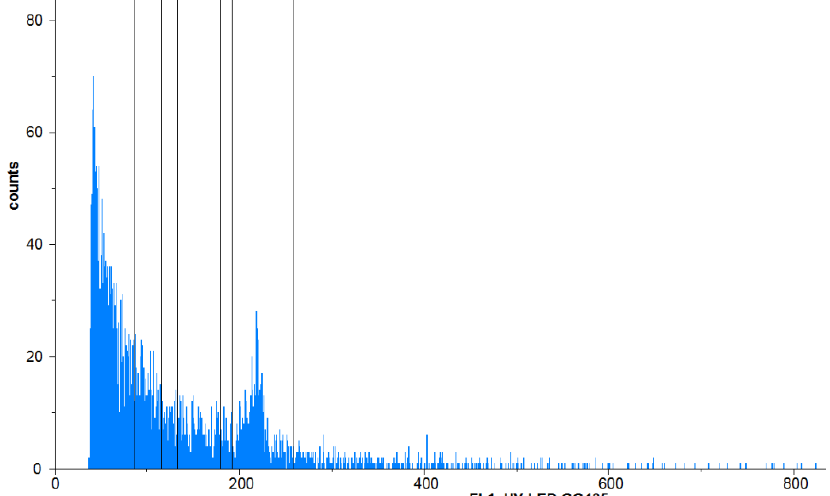
Figure 2. Argania spinosa flow cytometry profile 1, cells count represented on the Y axis while fluorescence intensity is represented on the X